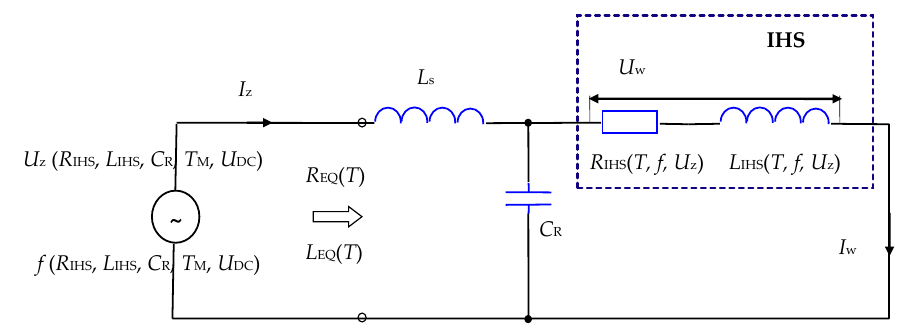
Figure 6. Source co-operation with a non-linear load for the LLC resonance system.